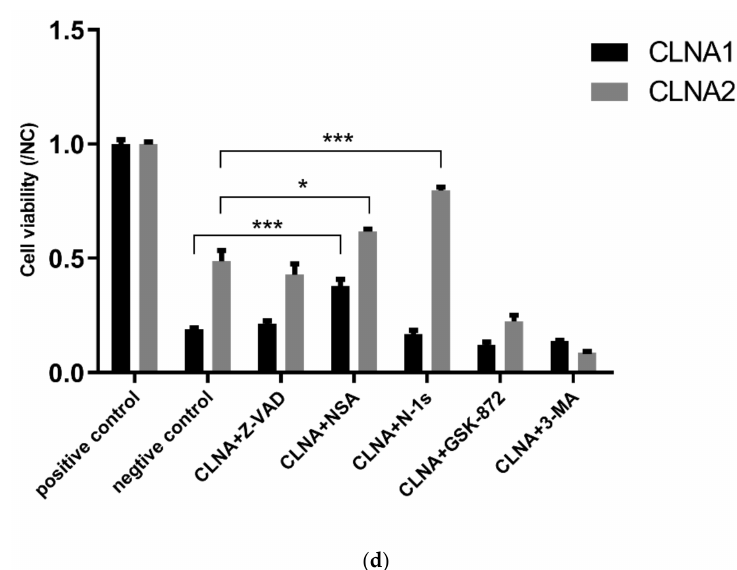
Figure 5. CLNA1 and CLNA2 induce Caco-2 cell death independent of apoptosis and autophagy. ( a ) The e ff ects of CLNA1 and CLNA2 on relative transcription levels of apoptosis-related factors PPAR γ , TNF- α and TGF- β in Caco-2 cells. ( b ) The e ff ects of CLNA1 and CLNA2 on expression of apoptosis proteins PARP-1, caspase-3, caspase-7 and caspase-9 in Caco-2 Cells. ( c ) Ratio of Caco-2 cells at each stage of di ff erent cell cycles after treatment with CLNA1 and CLNA2 under di ff erent concentrations for 48 h. ( d ) The e ff ects of di ff erent inhibitors on Caco-2 cells treated by CLNA1 and CLNA2 ( n = 6). NC indicated control group without CLNA treatment. Data are presented as mean ± SEM and at least three separate experiments were performed in all studies. * p < 0.05, ** p < 0.01 and *** p < 0.001 compared with